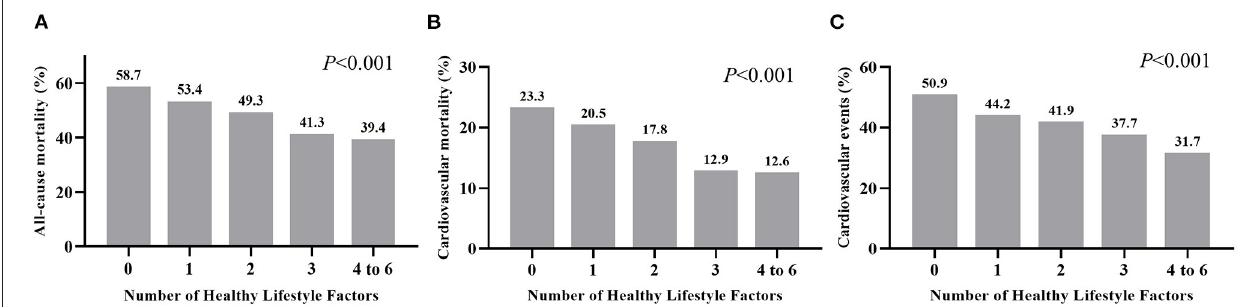
FIGURE 1 | Incidence of all-cause mortality (A) , cardiovascular mortality (B) , and cardiovascular events (C) grouped by number of healthy factors for diabetic individuals.